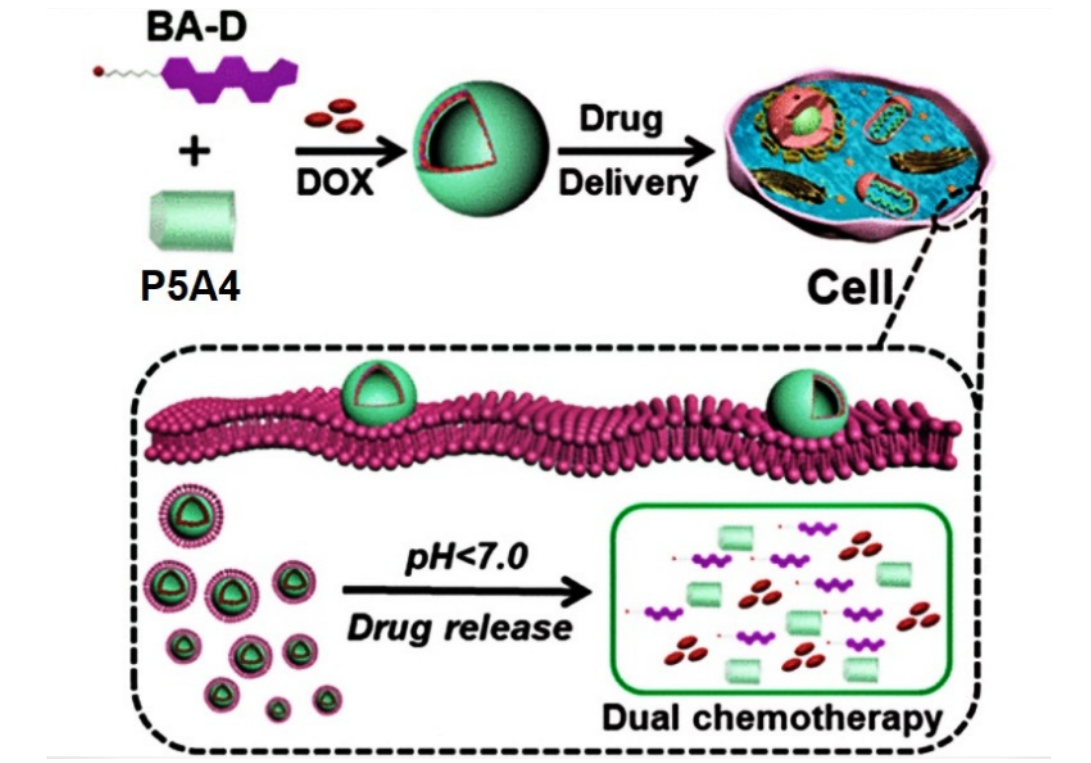
Figure 14. Schematic representation of the pH -responsive P5A4 -based tandem drug delivery system. Reproduced with the permission of reference [93]. Copyright © American Chemical Society 2022.